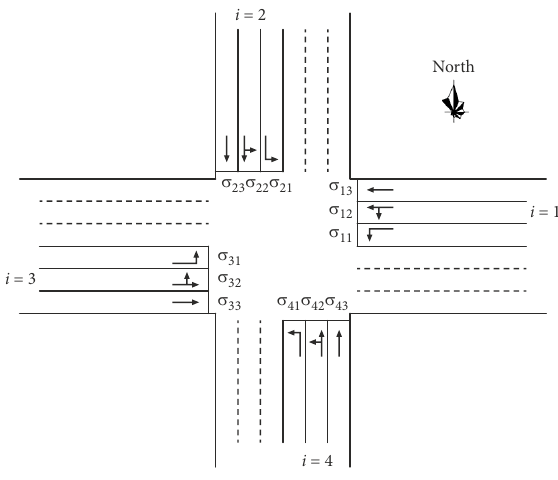
Figure 2. Movement